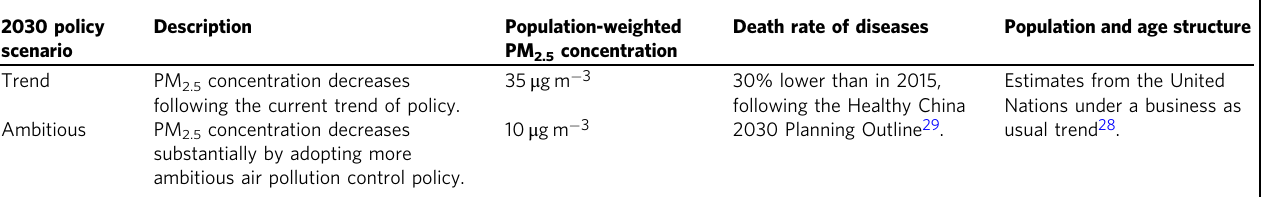
Table 2 Scenarios for projecting the deaths attributable to PM 2.5 pollution by 2030.